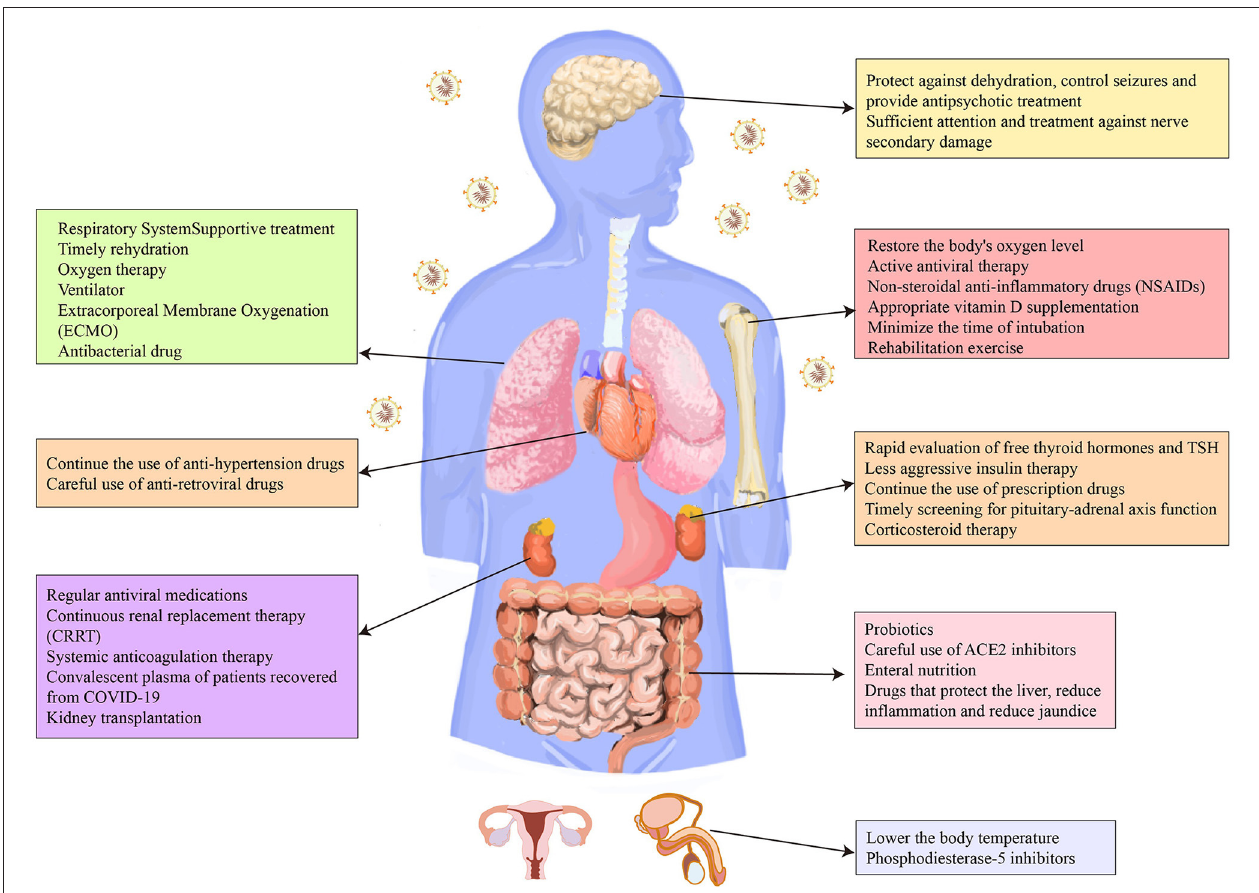
FIGURE 2 | Therapeutic strategies for the complications and sequelae of eight major systems caused by